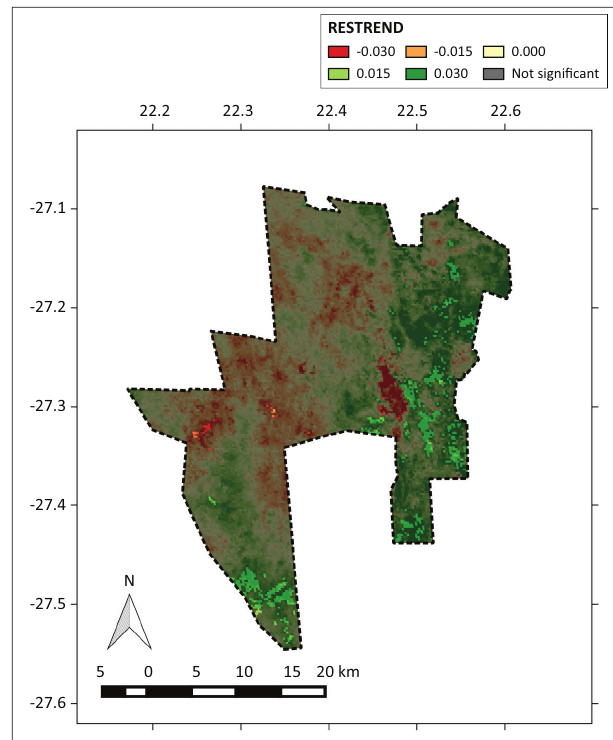
FIGURE 7: Map of the correlation of determination ( R 2 ) of the regression analysis of the annual rainfall for the growth seasons (explanatory variable) and small integrated value of the Enhanced Vegetation Index (responsive variable) between the 2001–2002 and 2013–2014 growth seasons, excluding the drought season of 2006–2007.